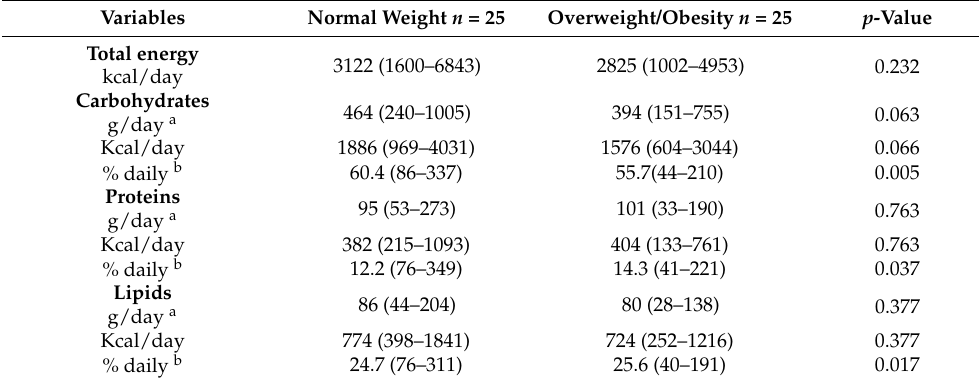
Table 4. Total energy and macronutrient intake in the study groups.